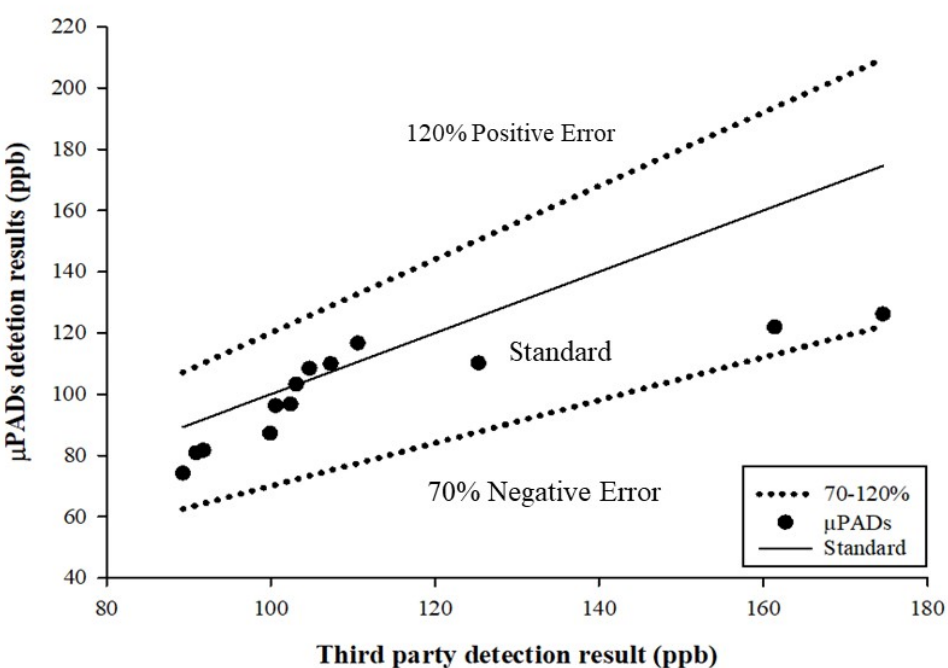
Figure 5. Scatter diagram for the measured sample. Table 1. Mercury assay results in comparison of different methods, using μ PADs, UV–Vis spec- trum, CVAAS, and third-party corporation for determination of mercury content.